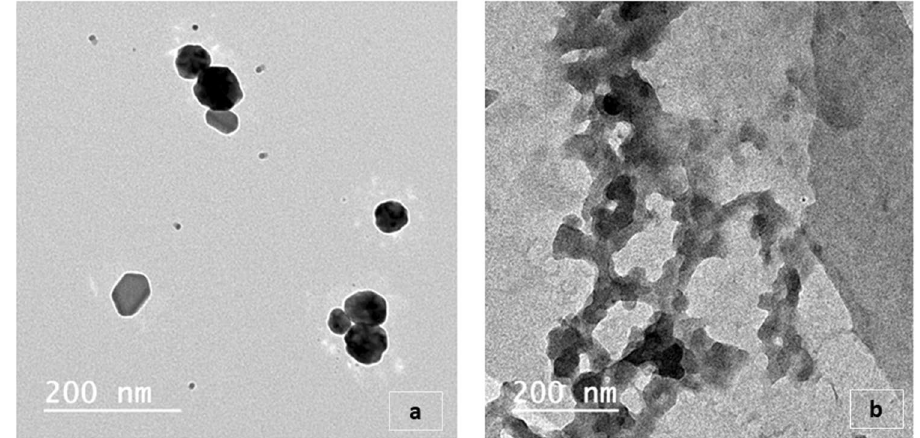
Figure 4. Transmission electron microscopy (TEM) images of silver nanoparticles before loading, showing a spherical like shape with diameters ranging amongst 36–60 nm ( a ) while in after loading ( b ), appears that the Virokill is completely encapsulates the silver nanoparticles.